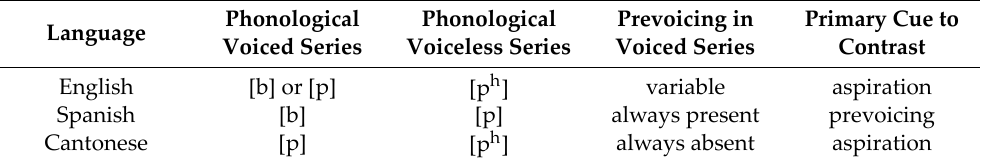
Table 1. Phonetic implementation of the word‑initial stop laryngeal contrast (using the example of labial stops) across the three languages relevant to this